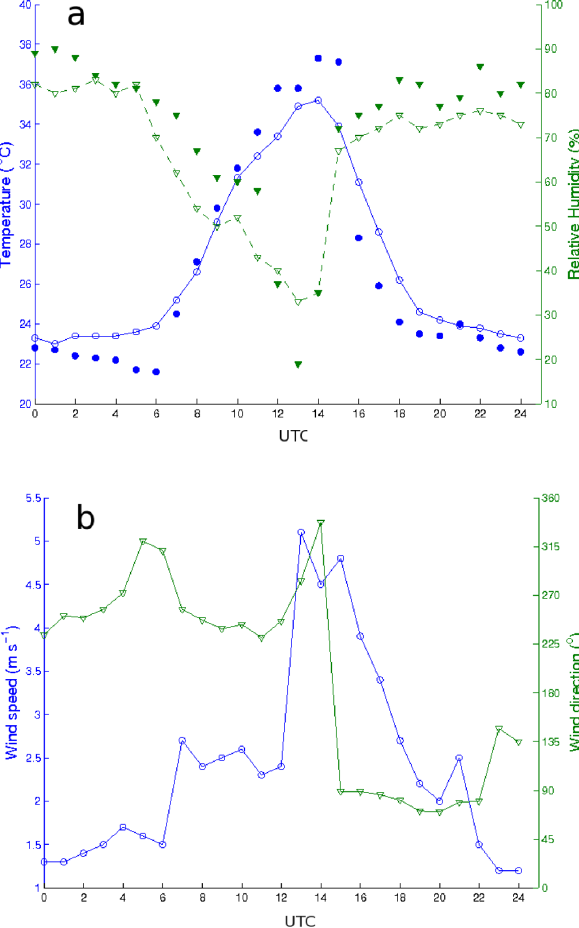
Fig. 2. Temporal evolution during 27 August 2010 of the 2m (a) temperature (blue) and relative humidity (green) and (b) wind ve- locity (blue) and direction (green) observed at Barcelona–Fabra weather station (closed symbols) and simulated by the WRF model (line and open